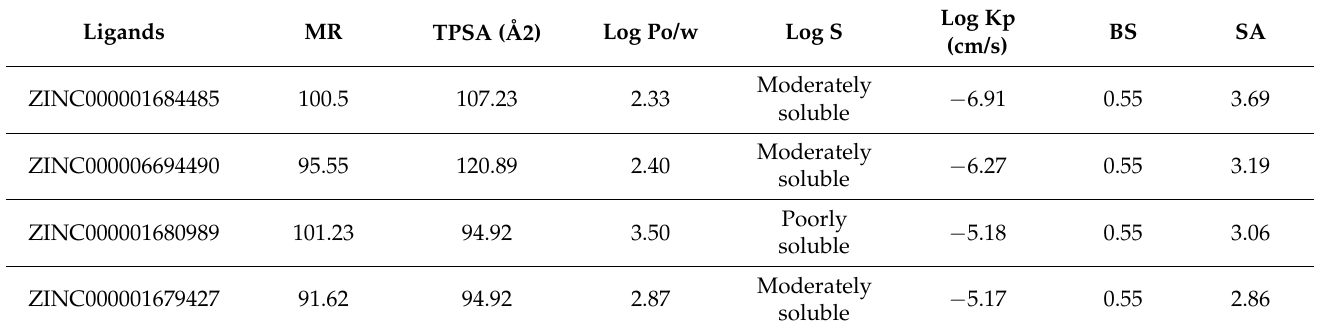
Figure 8. Frames in the function of time of the enzyme/ligand complexes. Table 4. Lipophilicity, druglikeness, solubility, physicochemical characteristics, pharmacokinetics and medicinal chemistry of the selected compounds evaluated by